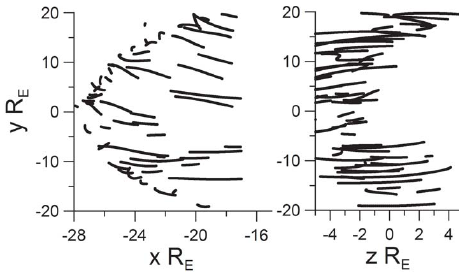
Figure 1. Fragments of Interball-tail orbits used in this